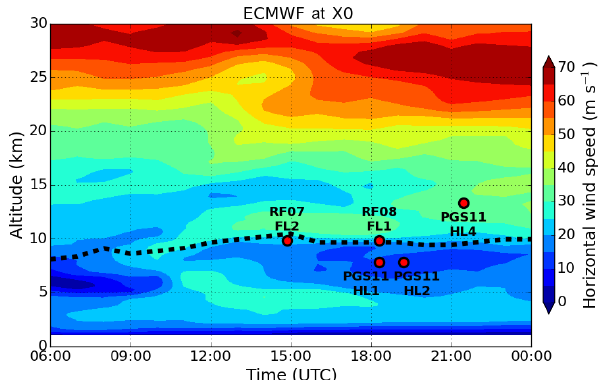
Figure 4. ECMWF time–height section of horizontal wind speed at point X 0 . The dashed black line marks the height of the thermal tropopause. Red dots mark the altitudes of HALO and Falcon at point X 0 of the respective flight legs (see also Fig. 1).